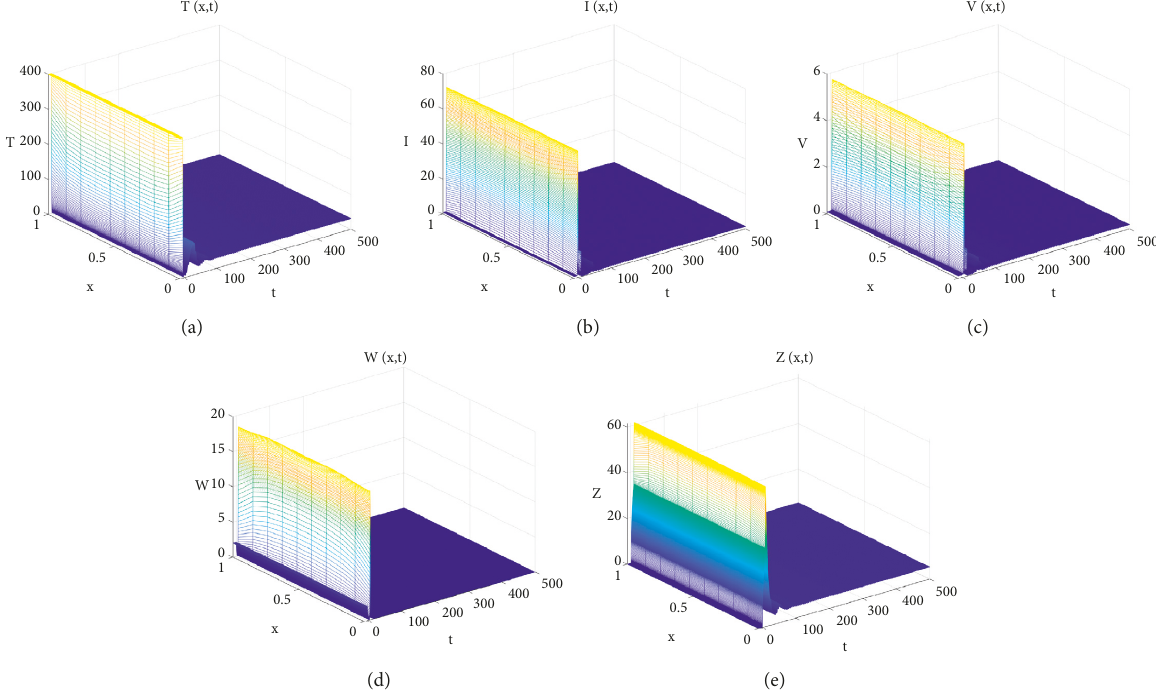
Figure 4: Taking β � 0 . 45, β � 0 . 15, c � 0 . 1, m � 0 . 001, δ � 1 . 5, h � 1, a � 0 . 5, k � 0 . 4, and b � 0 . 15, we have 1 2 � 374 . 7362 > 1 ,R � 14 . 1326 > 1, and R � 0 . 2883 < 1, E � ( 31 . 2314 , 1 . 5152 , 0 . 1922 , 0 , 6 . 5663 ) is asymptotically stable. R 0 2 4 3